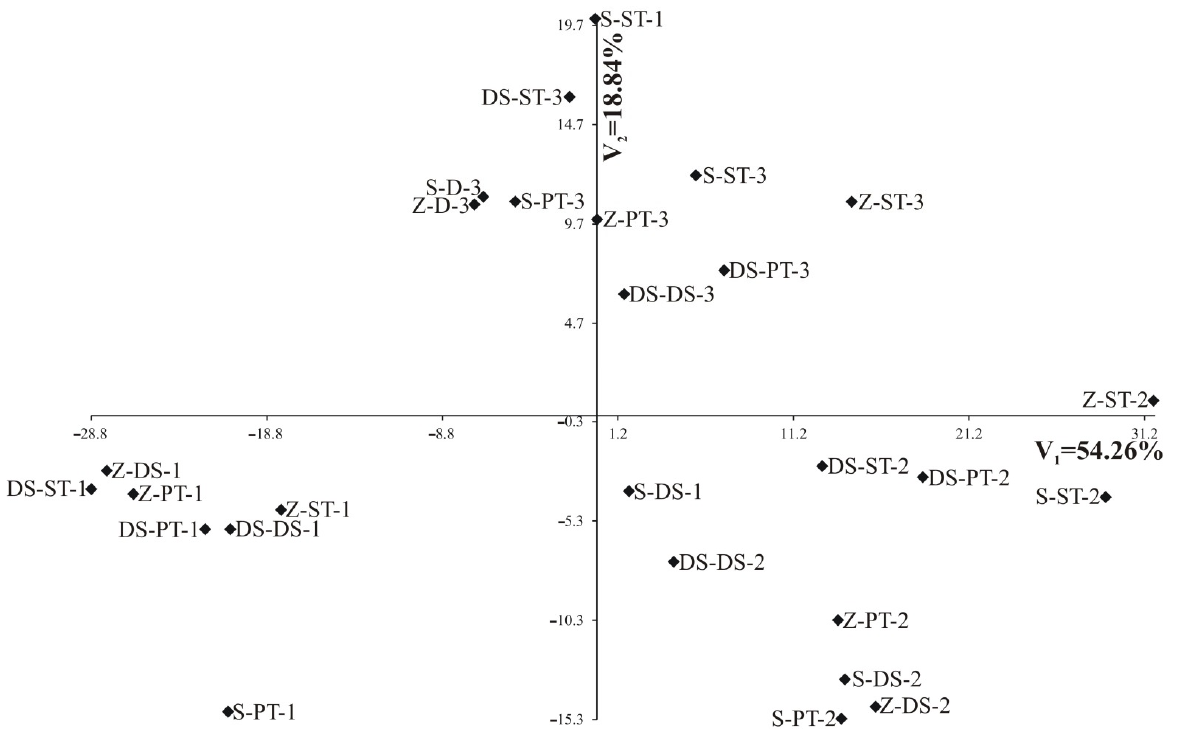
Figure 3. Distribution of the spring wheat treatments in the two first canonical variates at the 2nd term (cover crop: Z—zero, S—skimming, DS—direct sowing, ST—simplified tillage, PT—spring ploughing; years: 1—2011, 2—2012, 3—2013).